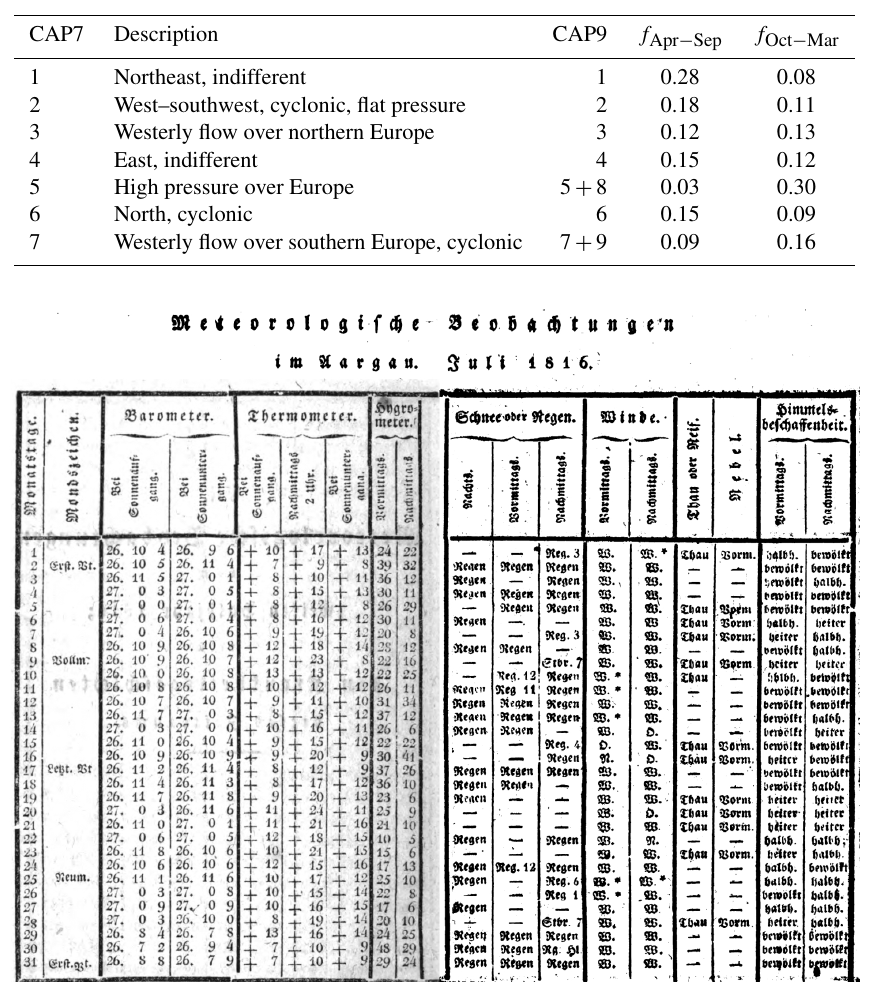
Figure 1. Weather observations by Zschokke, Aarau, for July 1816 (Zschokke,